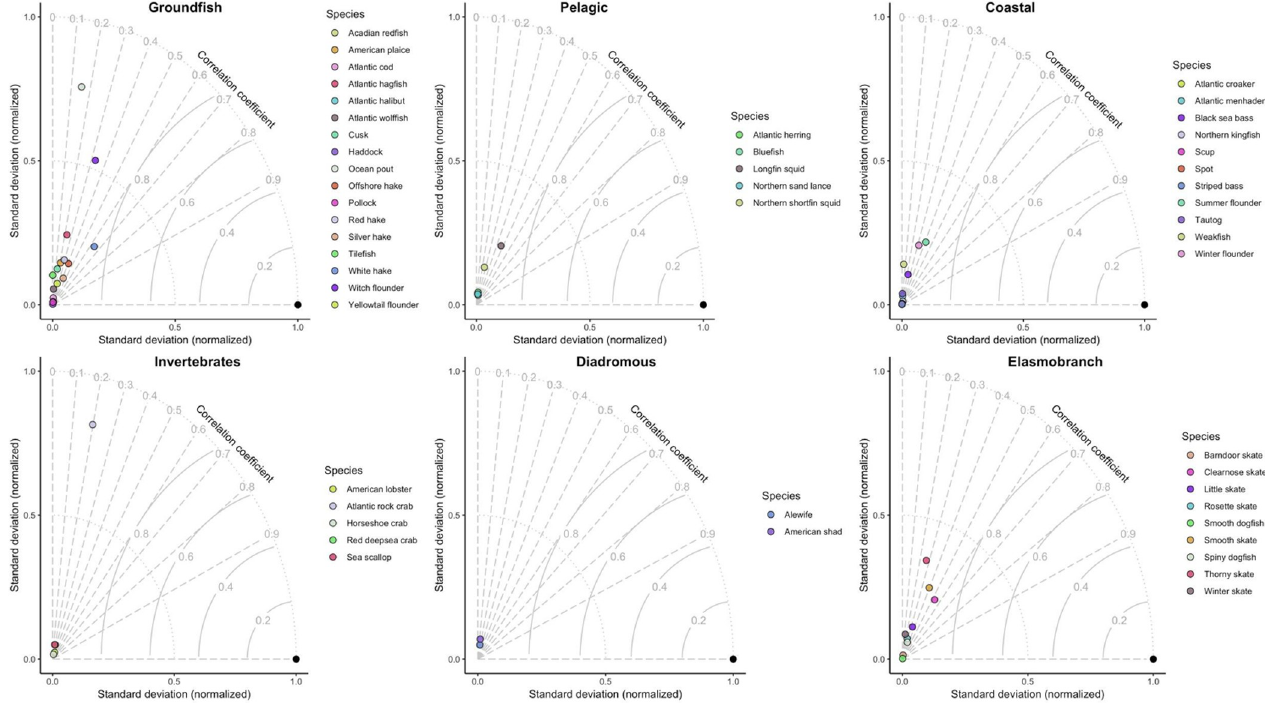
Fig 4. Taylor diagram of spring model predicted biomass compared to 2011–2015 observed biomass. The Taylor diagram provides a succinct picture of a model’s predictive ability and a detailed description of its features are provided in the caption for Fig 3.